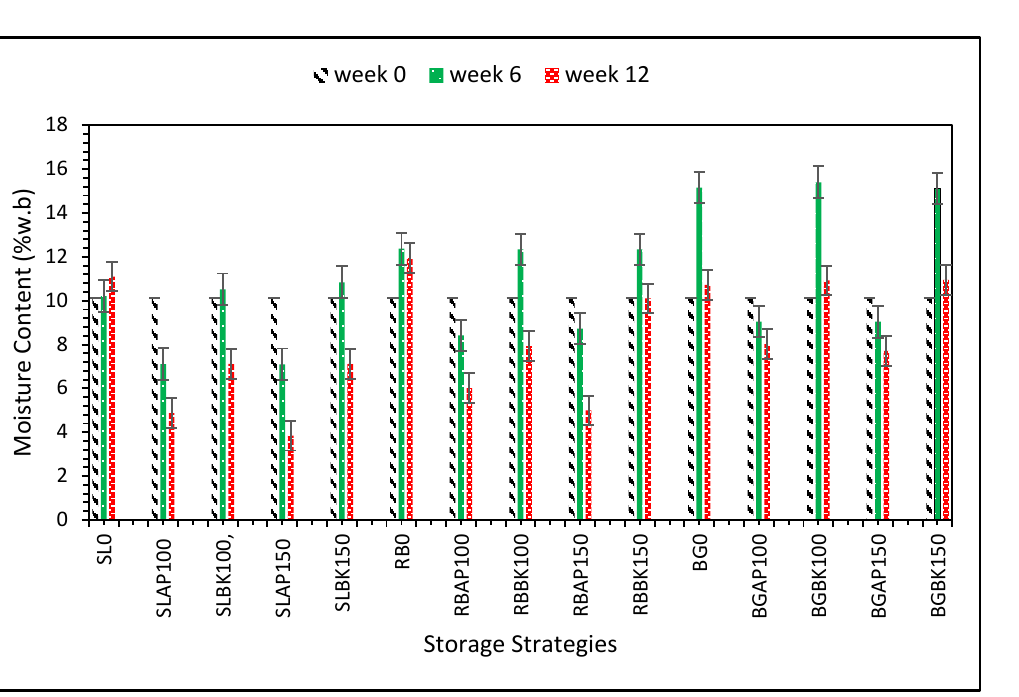
Figure 4. Variation in moisture content for different storage strategies within selected weeks.